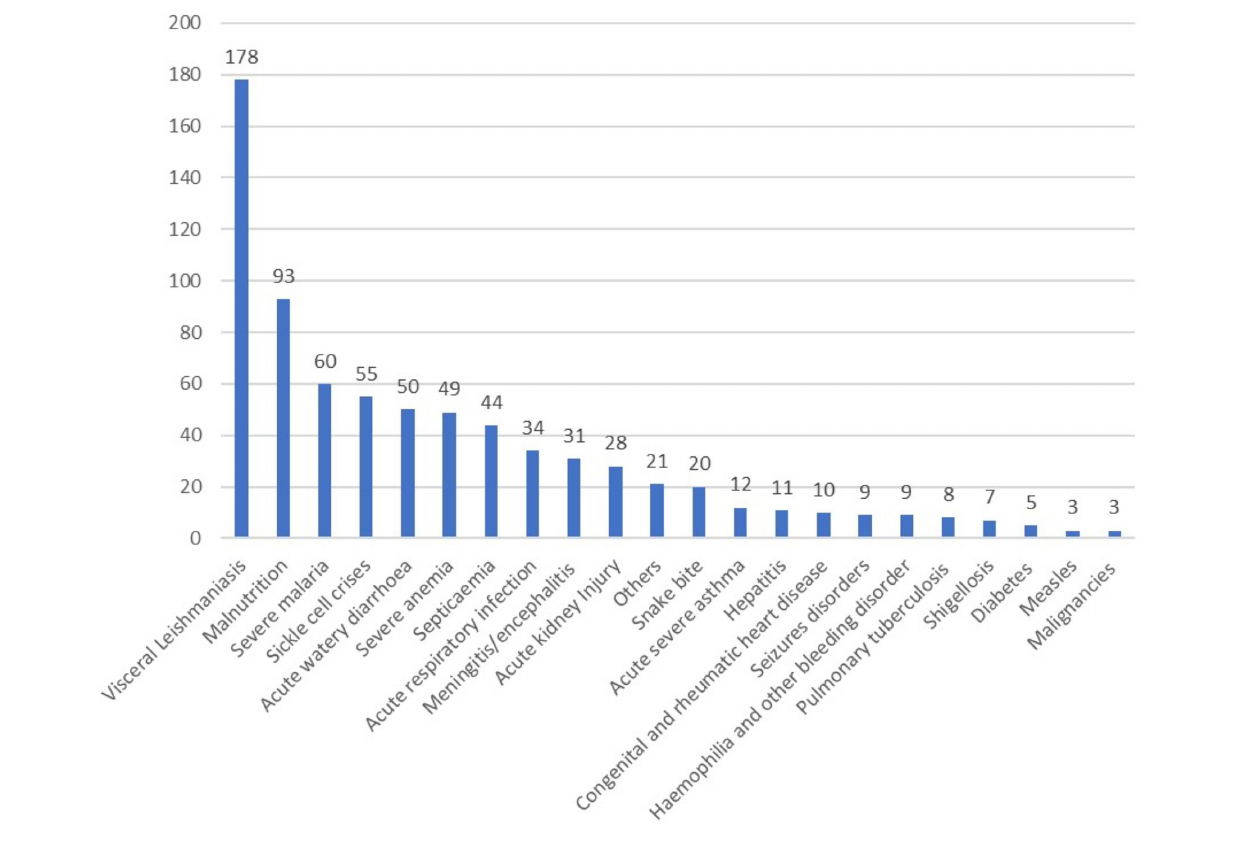
FIGURE 1 | Diagnosis on pediatrics admission in Gadarif Hospital in eastern Sudan in 2020 (number =